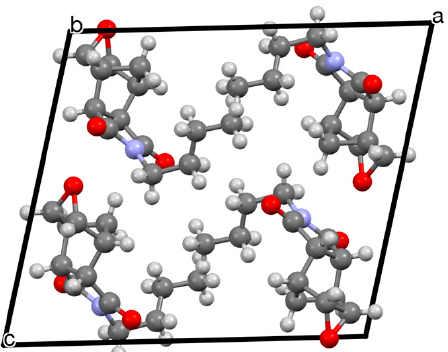
Figure 4. Unit cell of 3 viewed along the b axis showing alignment of the four molecules. In summary, the epoxy imide 3 is readily formed by spontaneous air oxidation of the corresponding unsaturated imide 2 and preparation of the related epoxy anhydride 4 allowed unambiguous assignment of 1 H- and 13 C-NMR spectra for all three compounds. The X-ray structure for 3 confirms the configuration and shows similar inter-ring angles to related tetracyclic